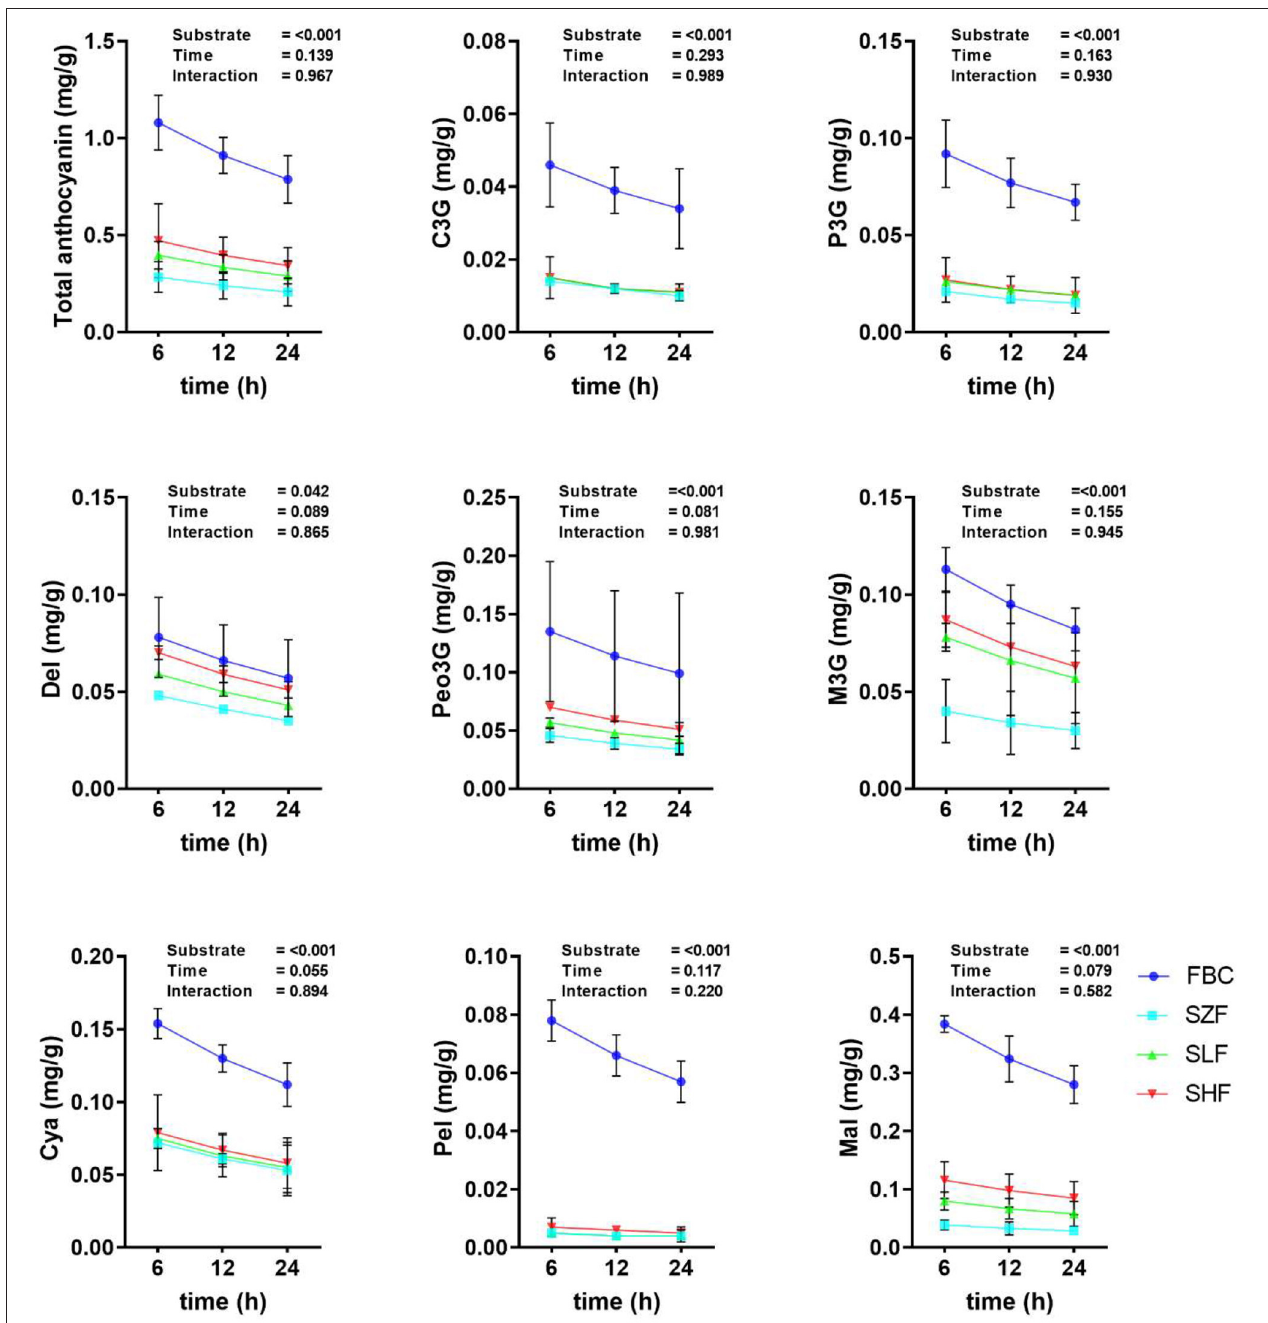
FIGURE 2 | The anthocyanin concentration of black cane prior to ensiling (pre-ensiled materials) and silages treated with ferrous sulfate heptahydrate, at three time points (6, 12, 24h) during the in vitro rumen incubation (means ± SEM; n = 18). C3G, cyanidin-3-glucoside; P3G, pelargonidin-3-glucoside; Del, delphinidin; Peo3G, peonidin-3-O-glucoside; M3G, malvidin-3-O-glucoside; Cya, cyanidin; Pel, pelargonidin; Mal, malvidin; FBC, pre-ensiled materials; SZF, ensiled FBC + 0% ferrous sulfate heptahydrate; SLF, ensiled FBC + 0.015% ferrous sulfate heptahydrate; SHF, ensiled FBC + 0.030% ferrous sulfate heptahydrate. Overall, substrate effect, P < 0.05; incubation time, P < 0.05; interaction, P <